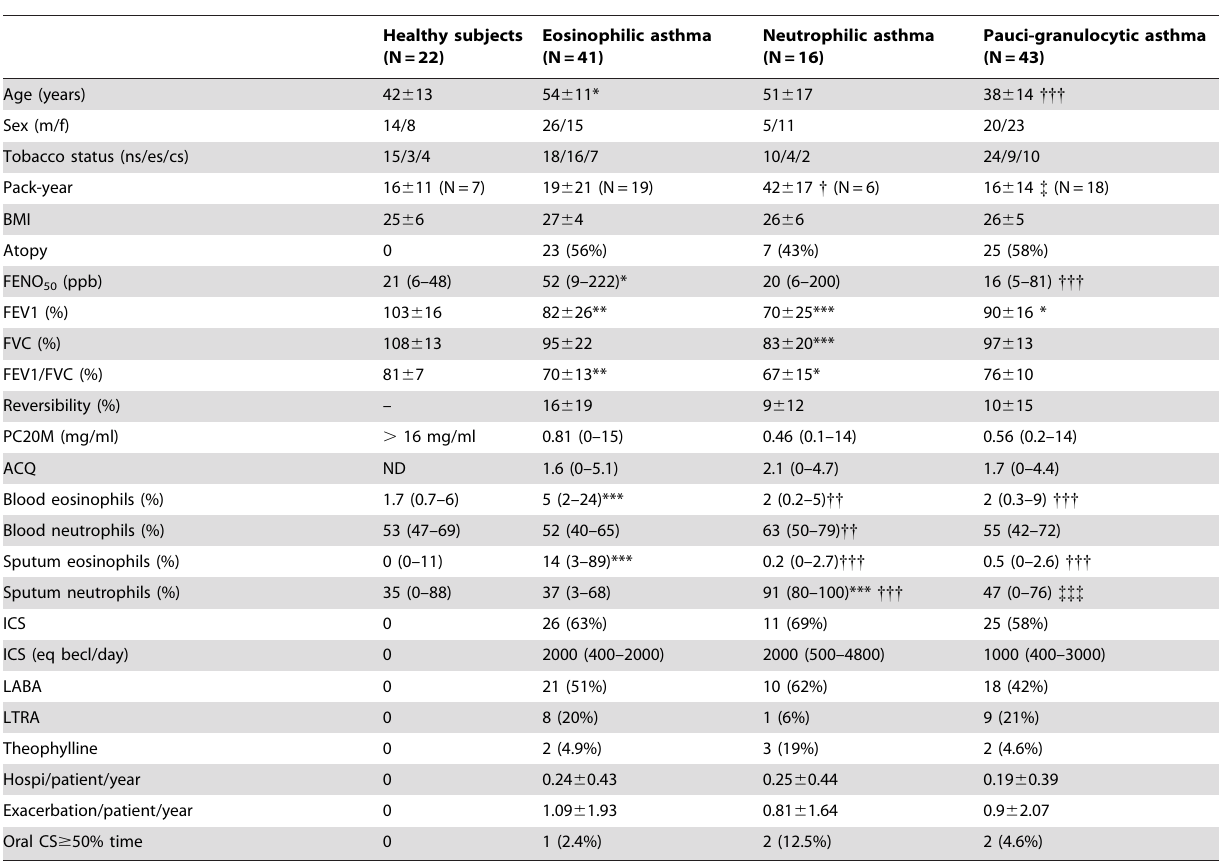
Table 1. Demographic, functional, airway inflammatory and treatment characteristics according to sputum cellular